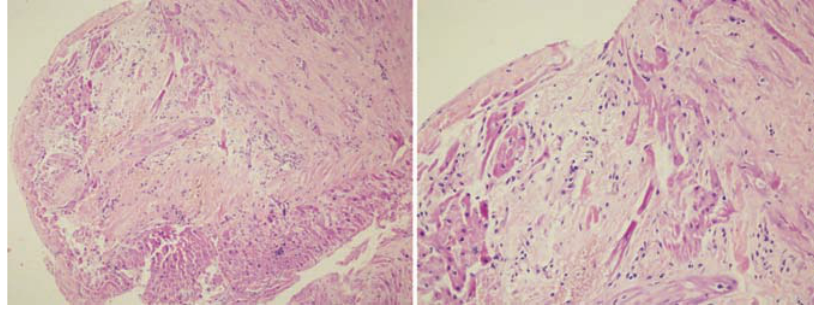
Figure 1. Microphotographs showing thickened endocardium (left) and replacement fibrosis with myocyte atrophy and anisonucleosis (right).(H & E X 280).